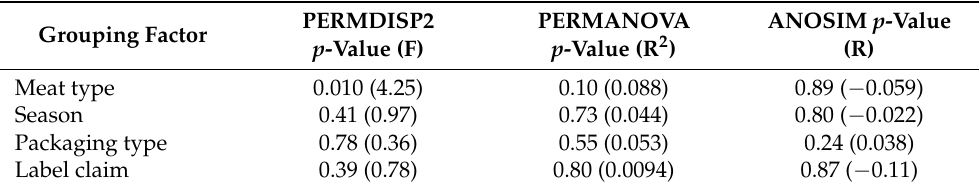
Table 5. Results of PERMDISP2, PERMANOVA, and ANOSIM tests based on the presence and absence of AMR genetic determinants. All tests were performed using a Jaccard distance metric and 10,000